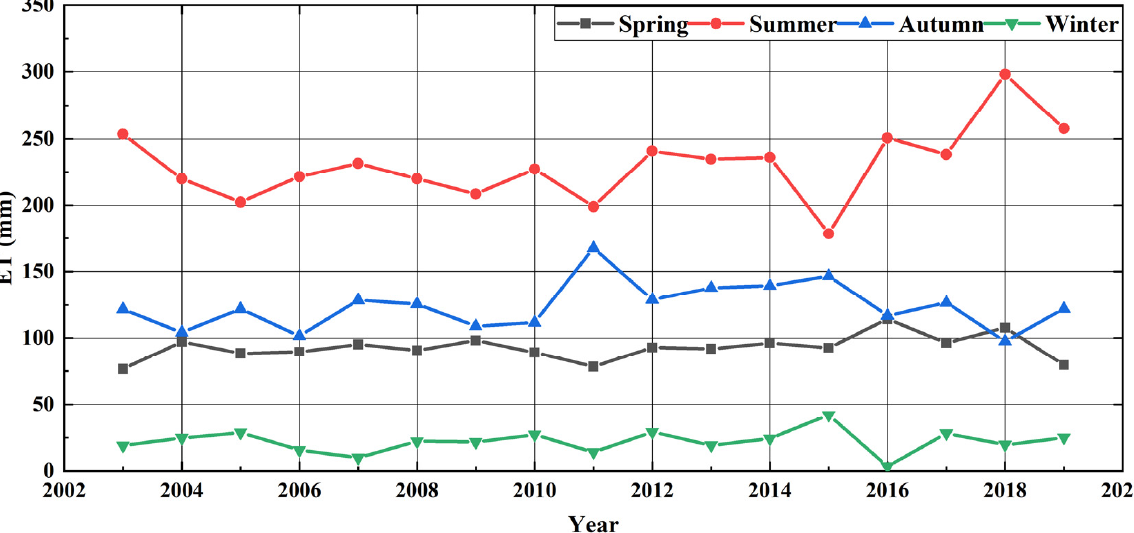
Figure 10. Time series of evapotranspiration (ET) calculated by Gravity Recovery and Climate Experiment (GRACE)/GRACE Follow-On (GRACE/GRACE-FO) in the Yellow River Basin in different seasons.